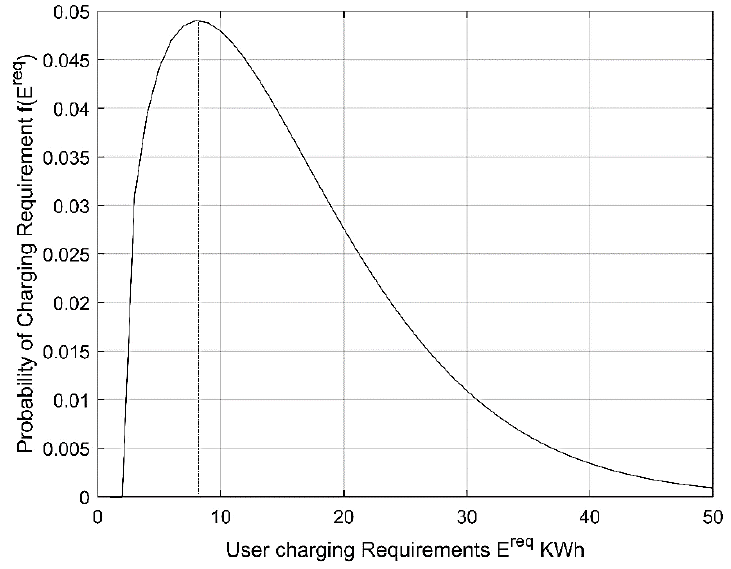
Figure 3. Weibull density probability for EV charging energy requirement.